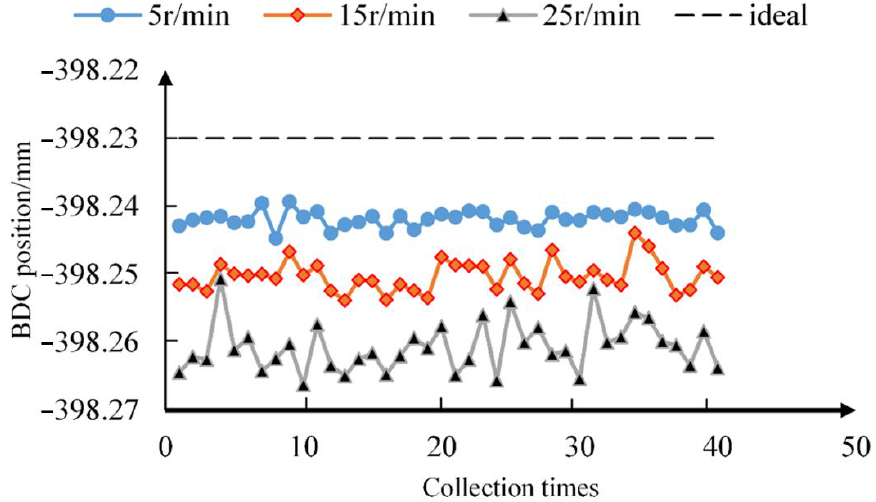
Figure 10. Positions of the bottom dead point at different speeds.